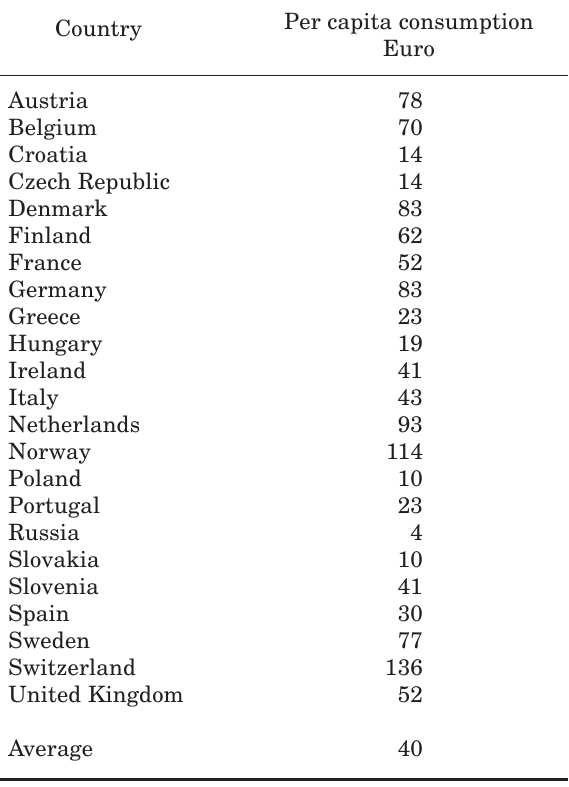
Table 2. Per capita consumption in European countries. Values are expressed in Euro and referred to